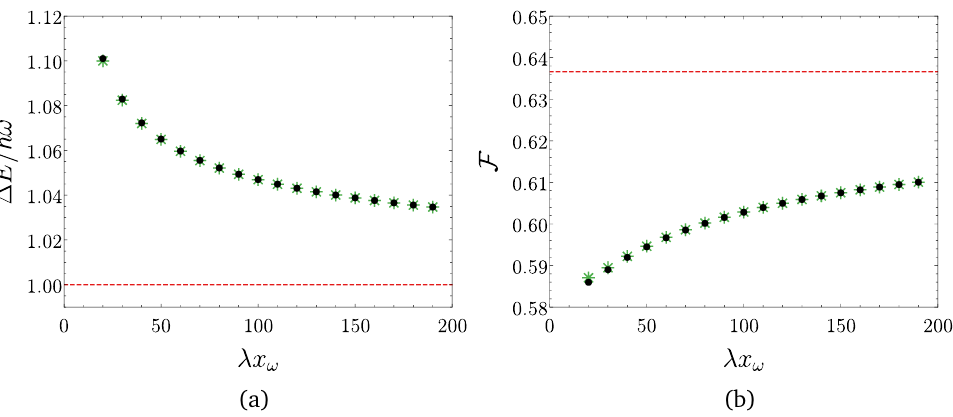
Figure 1: a) Energy for two pairs, excluding the trivial contribution equal to twice the single-pair energy, as a function of λ . b) Fidelity between the coboson ansatz and the numerically found ground state as a function of λ . The results are obtained from the lowest non-trivial order of the Taylor expansion (green stars) and the next non-zero higher-order corrections (black circles) as reported in Appendix A. The horizontal dashed red lines indicate the asymptotic values for λ → ∞